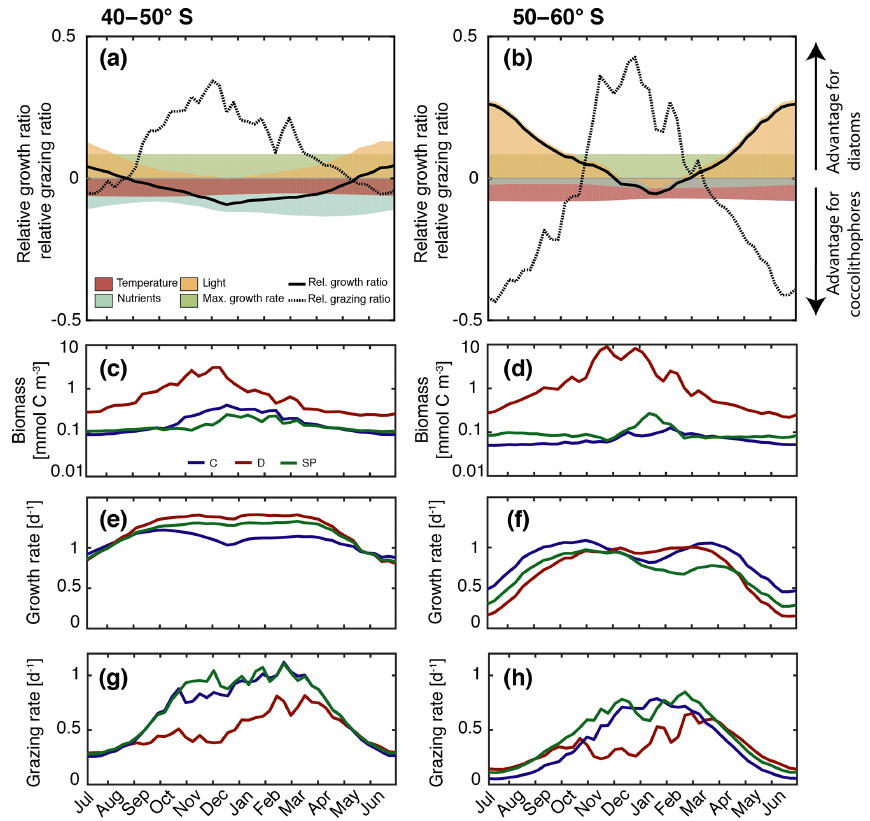
Figure 5. (a–b) Relative growth ratio (solid black line) and relative grazing ratio (dashed black line) of diatoms vs. coccolithophores. Colored areas are contributions of the maximum growth rate µ max (green), nutrient limitation (blue), light limitation (yellow), and temperature sensitivity (red) to the relative growth ratio, e.g., the red area represents the term β T of Eq. (4) (see Sect. 3). (c–d) Surface carbon biomass evolution (mmolCm − 3 ), (e–f) specific growth rates (d − 1 ; Eq. 3), and (g–h) biomass-normalized specific grazing rates (d − 1 , Eq. 6). For (c–h) , coccolithophores (C) are shown in blue, diatoms (D) in red, and small phytoplankton (SP) in green. For all metrics, left panels are for 40–50 ◦ S, and those on the right are for 50–60 ◦